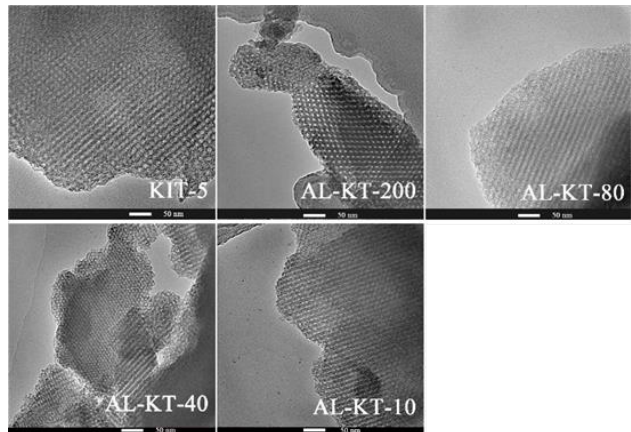
Figure 6. The transmission electron microscopy images of the Al-KT-X and KIT-5 supports.